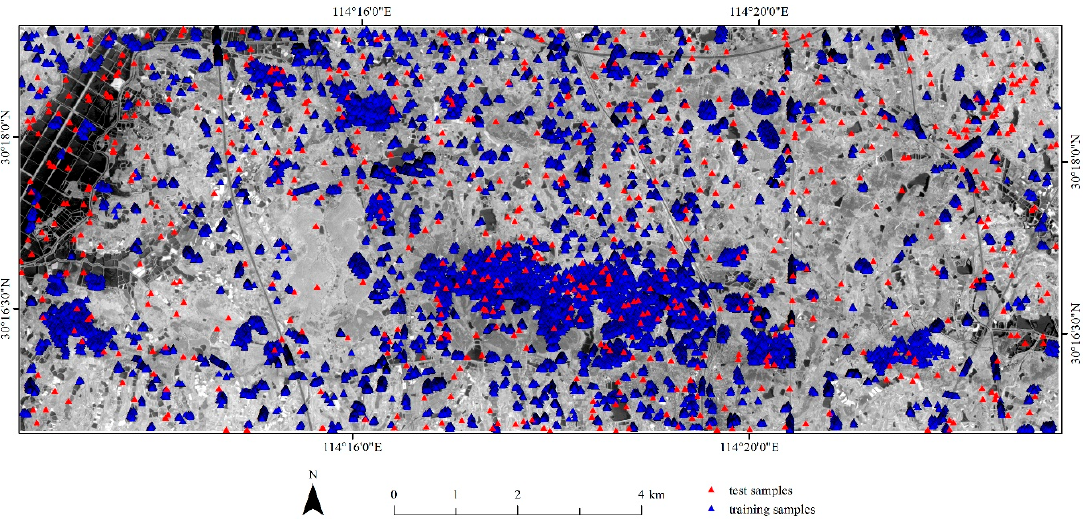
Figure 2. Location of training and test samples and the red band of ZiYuan-3 fused image.